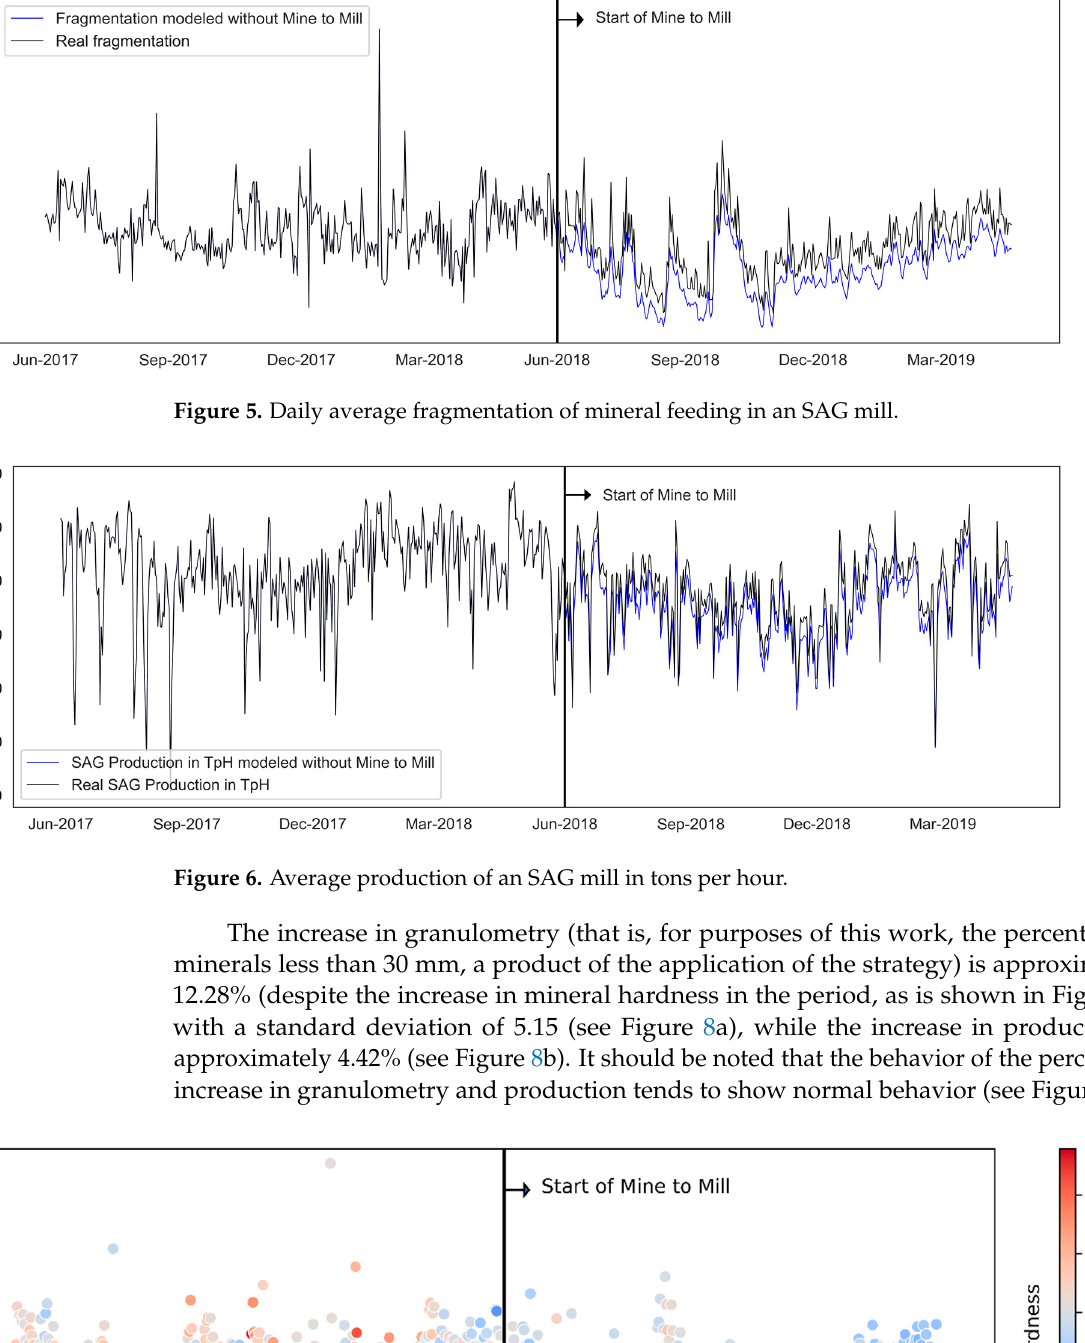
Figure 7. Variation of mineral hardness.